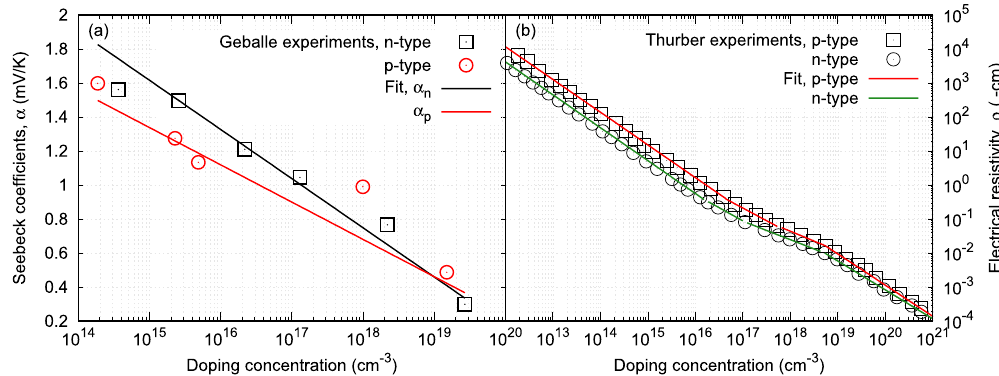
Figure 2. ( a ) Seebeck coefficients measured at different doping concentrations (data points) 24 . Lines are the coefficient fitting functions used in the thermocouple simulations. ( b ) Electrical resistivity measured at different doping concentrations and then fitted into the analytical functions (data points) 25 . Lines are the resistivity piece- wise fitting functions used in the thermocouple simulations.